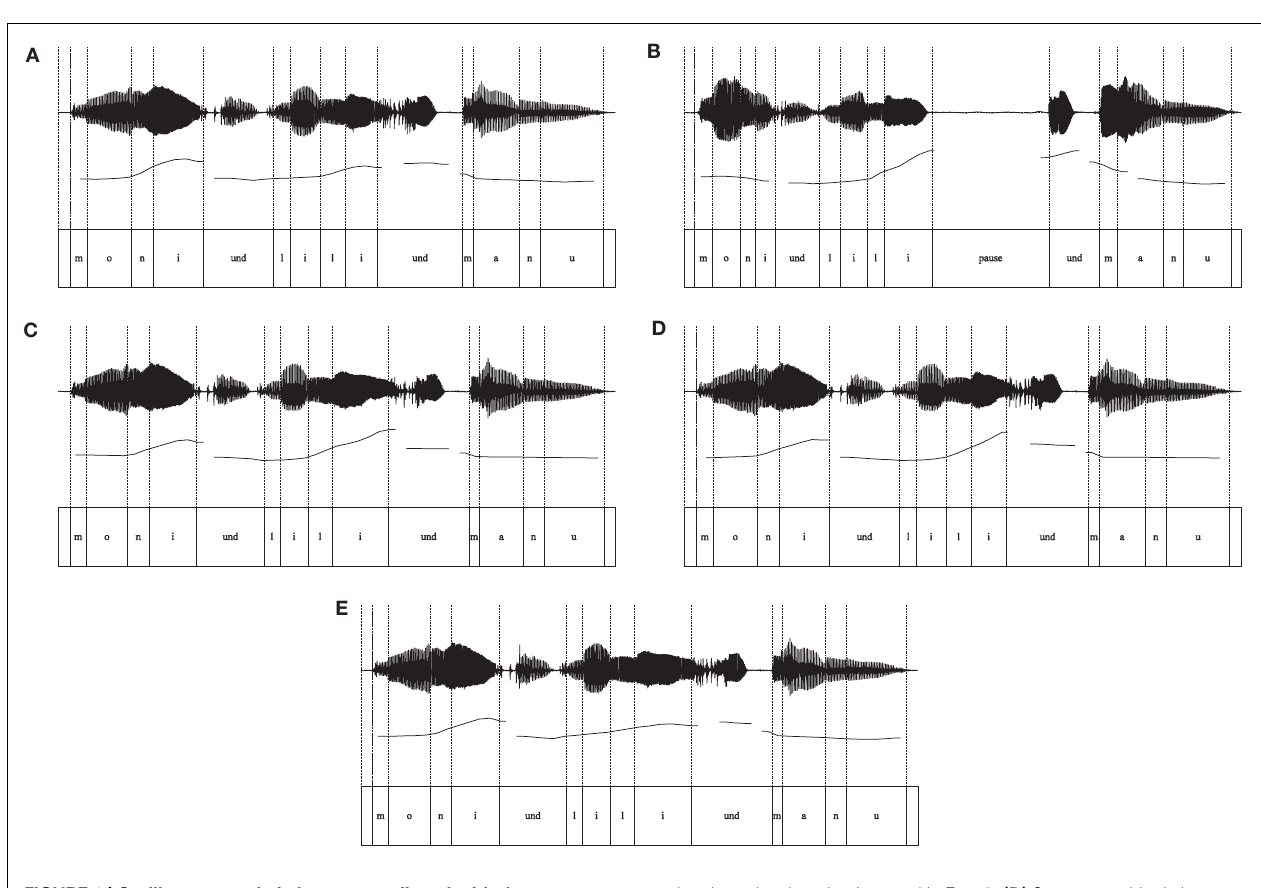
FIGURE 1 | Oscillograms and pitch contours aligned with the text. (A) Sequence without an internal IPB used in Exp. 1, (B) Sequence with an internal IPB used in Exp. 1, (C) Sequence with pitch change